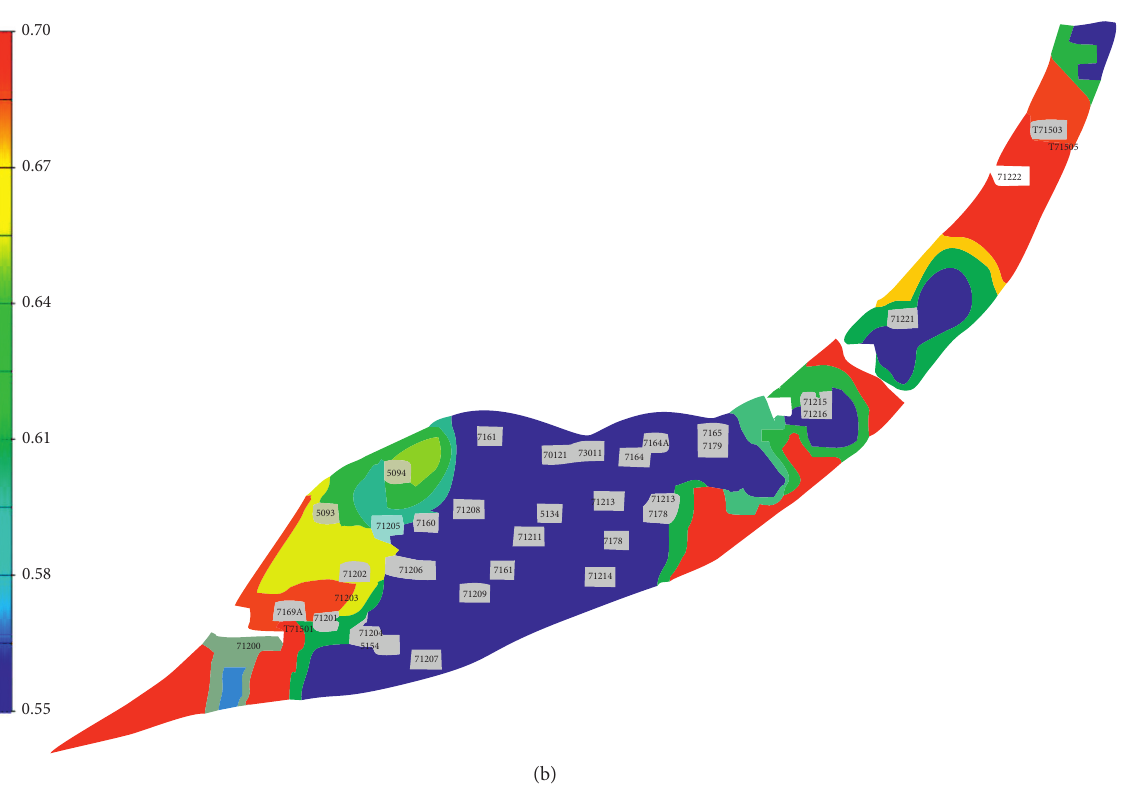
Figure 6: Oil saturation of (a) K 72 and (b) K 74 (at present).